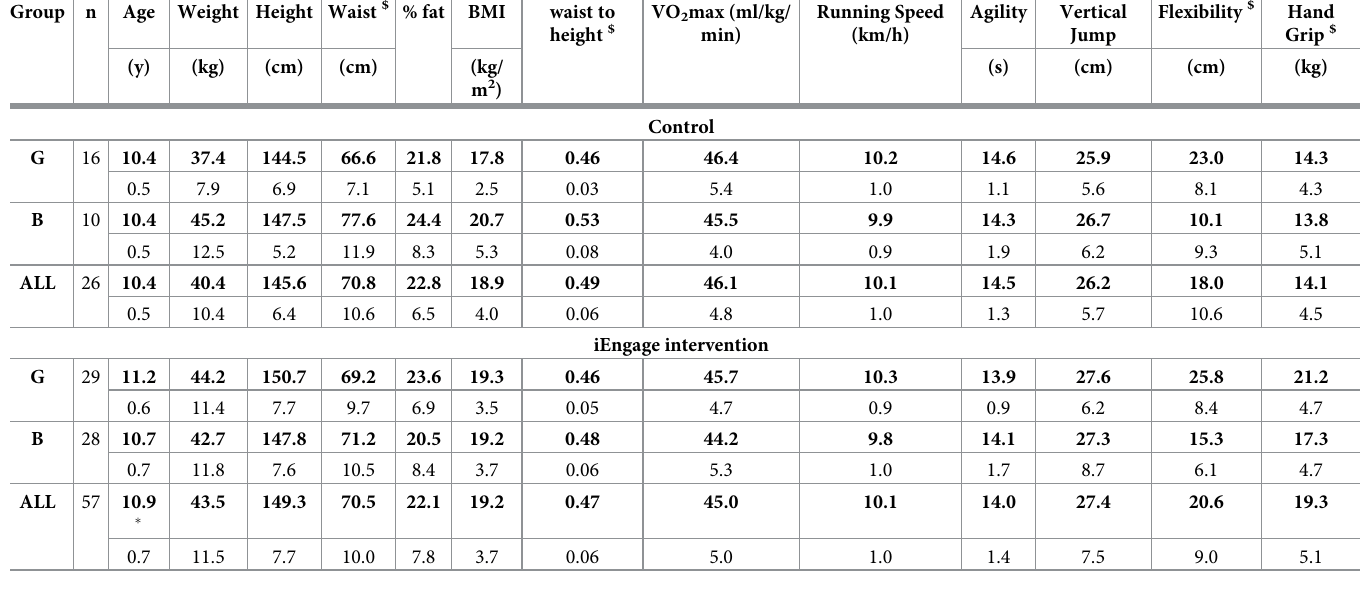
Table 1. Participants’ age, physical measures and physical fitness (G: Girls, B: Boys). Group